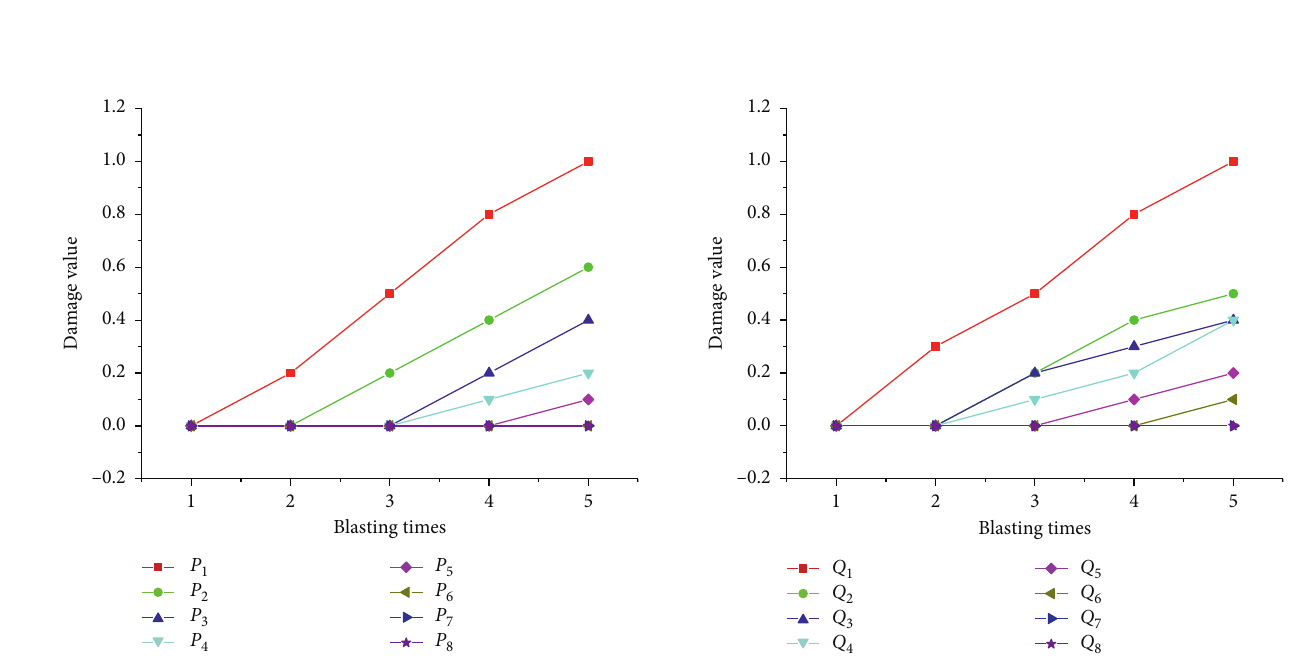
Figure 11: Cumulative damage nephogram of surrounding rock and rock anchor beam concrete under blasting. (a) 3.1 ms, (b) 6.1 ms, (c) 9.1 ms, (d) 12.1 ms, and (e) 15.0 ms.